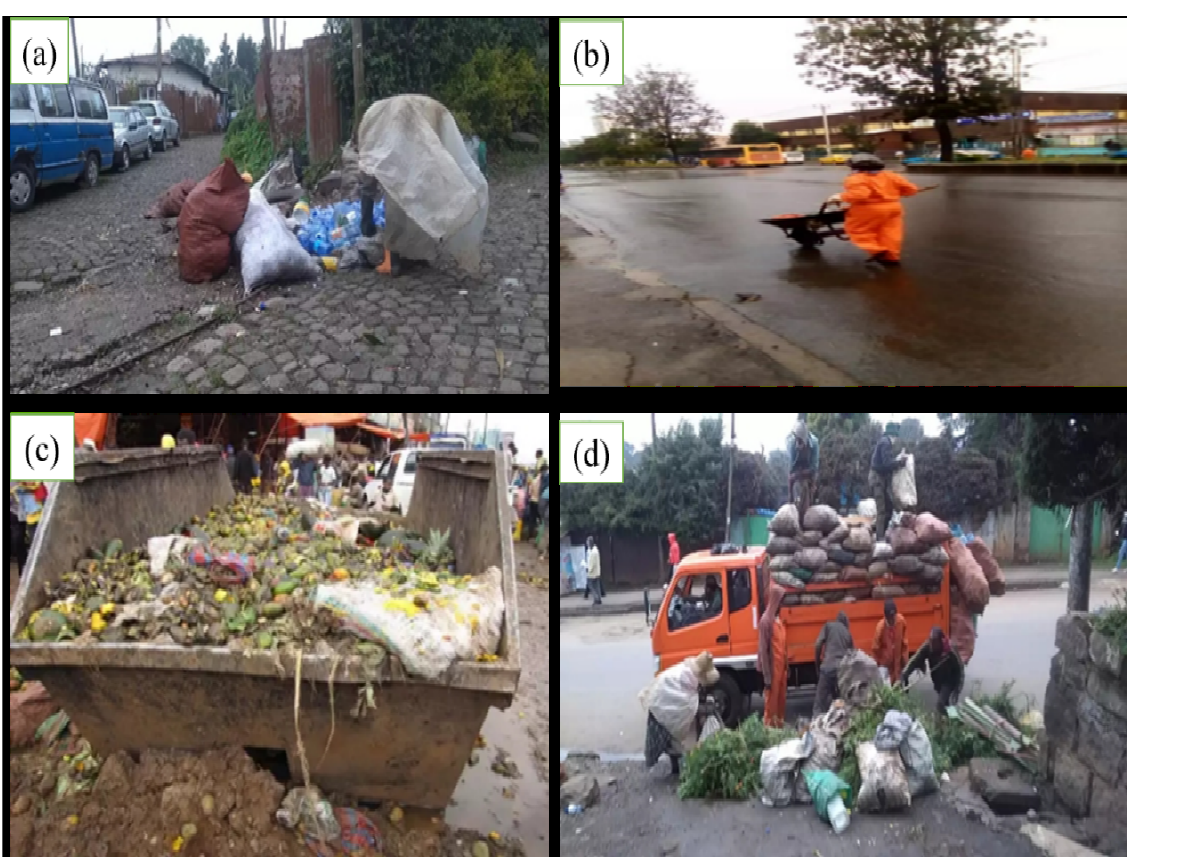
Figure 4. Dry waste gathering and transportation system in Addis Ababa Source: Field survey (September